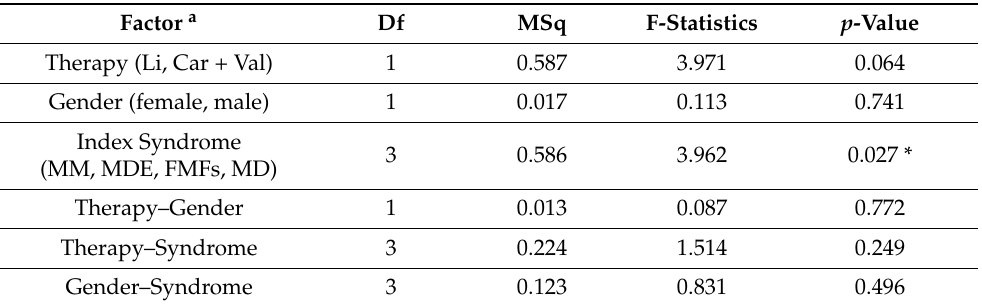
Table 5. Relationships between response (full and partial prophylactic effect group and no effect group) and mood stabilizing agent, gender, and syndrome (three-way